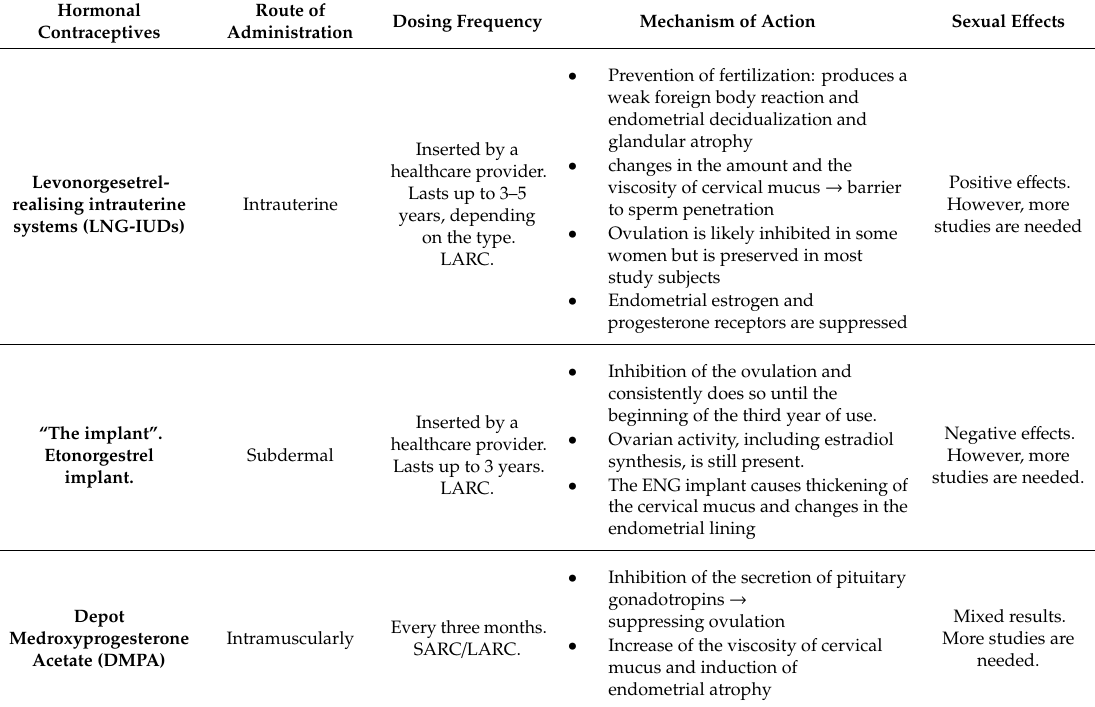
Table 1. Hormonal contraceptives. Route of administration, dosing frequency, mechanism of action, and association with sexual e ff